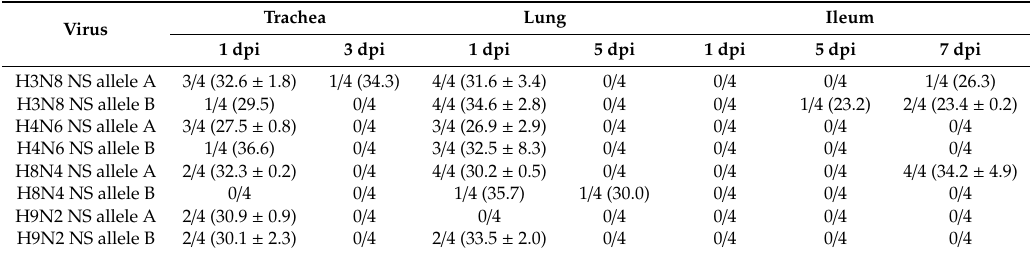
Table 1. Viral replication in the trachea, lung and ileum. The ratio of chickens virus-positive in tissue to the number of virus-inoculated chickens. The tissues were collected from four euthanized birds of each experimental group at 1, 3, 5, and 7 days post inoculation (dpi). Virus was detected by